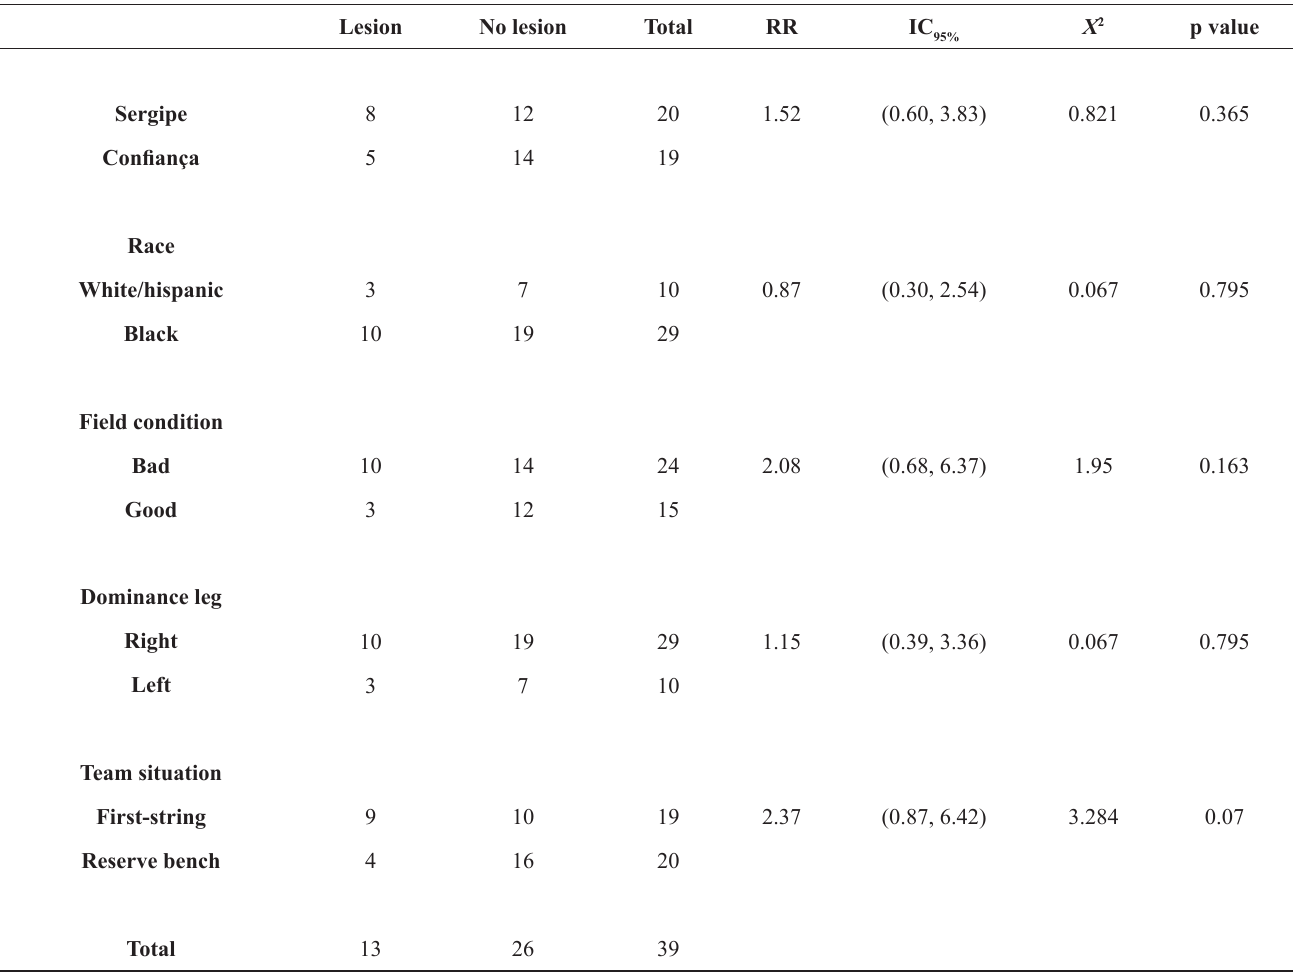
Table 3. Statistical evaluation of the association between each variable and the outcome. Sergipe, Brazil, 2014. Lesion No lesion Total RR IC